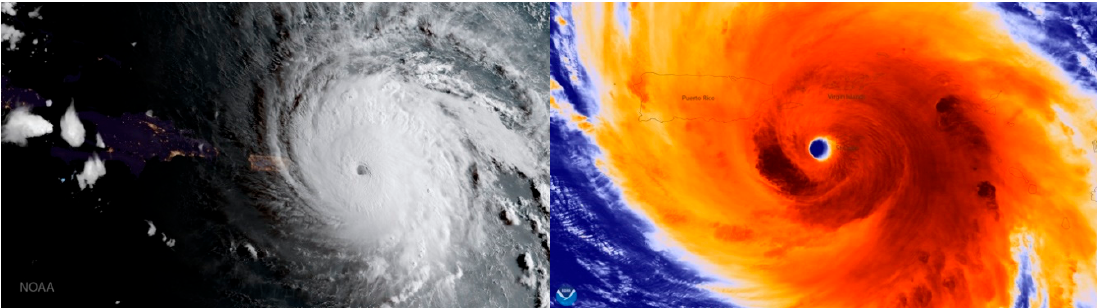
Figure 1. Visible Infrared Imaging Radiometer Suite (VIIRS) satellite images of hurricanes Irma (left) and Maria (right) using I-band 5 (11 um). Images courtesy of NOAA National Environmental Satellite, Data, and Information Service (NESDIS).